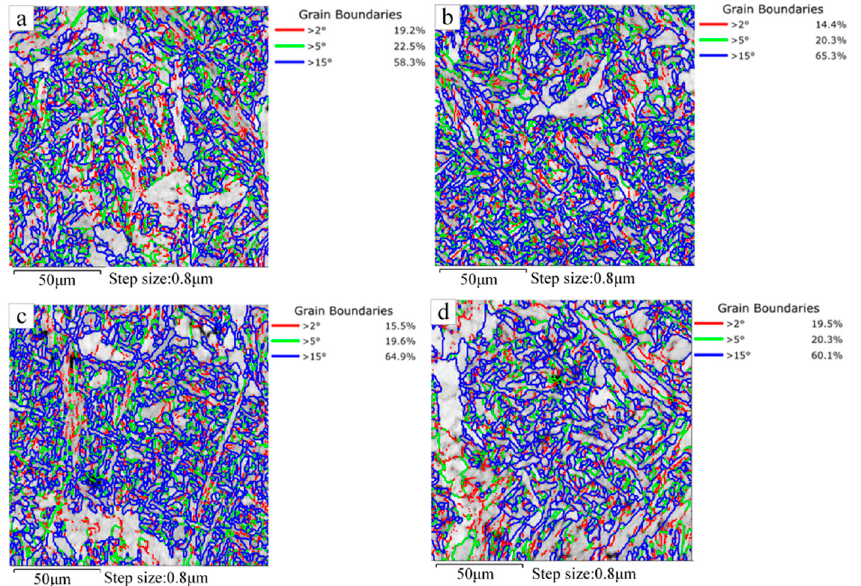
Figure 11. Grain boundary types in X80 steel welded joints. ( a ) In air and ∆ K , is 45 MPa·m 1/2 ; ( b ) in air and ∆ K , is 60 MPa·m 1/2 ; ( c ) in water and ∆ K , is 45 MPa·m 1/2 ; ( d ) in water and ∆ K , is 60 MPa·m 1/2 .